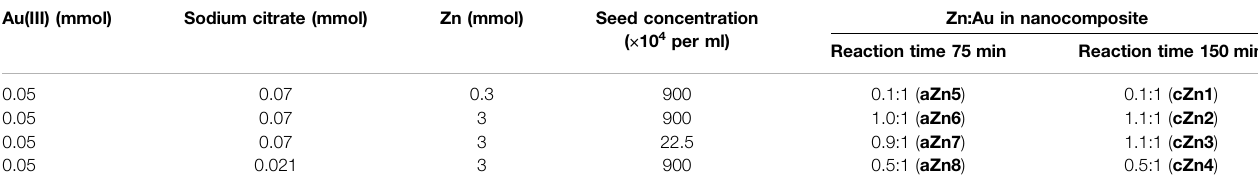
TABLE 1 | Summary of Au-ZnO nanocomposites based on EDX analysis from FE-SEM. Au(III) (mmol) Sodium citrate